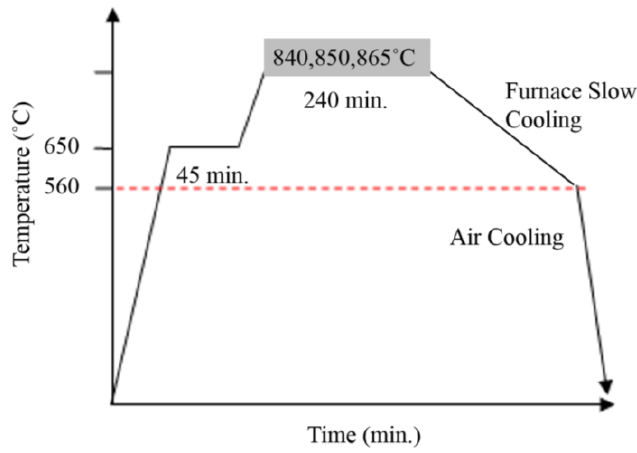
Figure 3. Schematic of various working temperatures of annealing heat treatment processes.